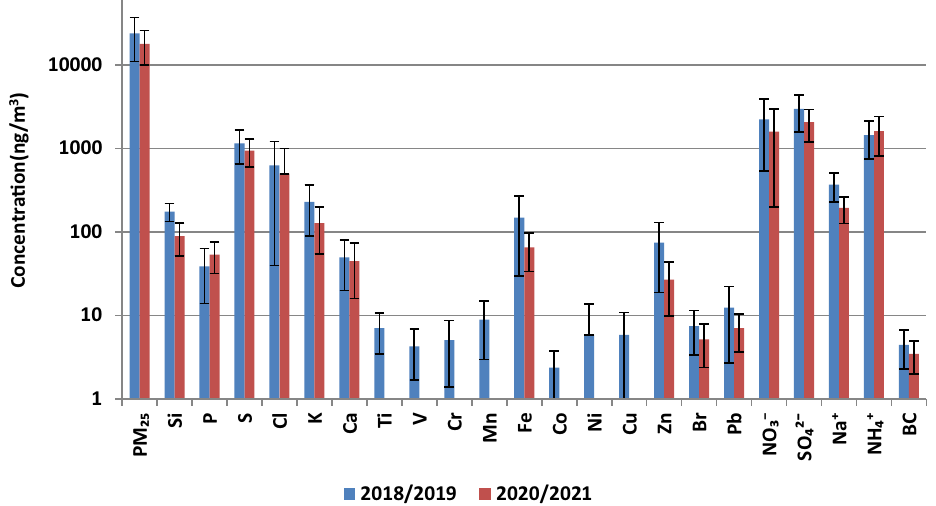
Figure 3. Annual concentration of PM 2.5 , chemical elements, ions and equivalent black carbon with standard deviation.